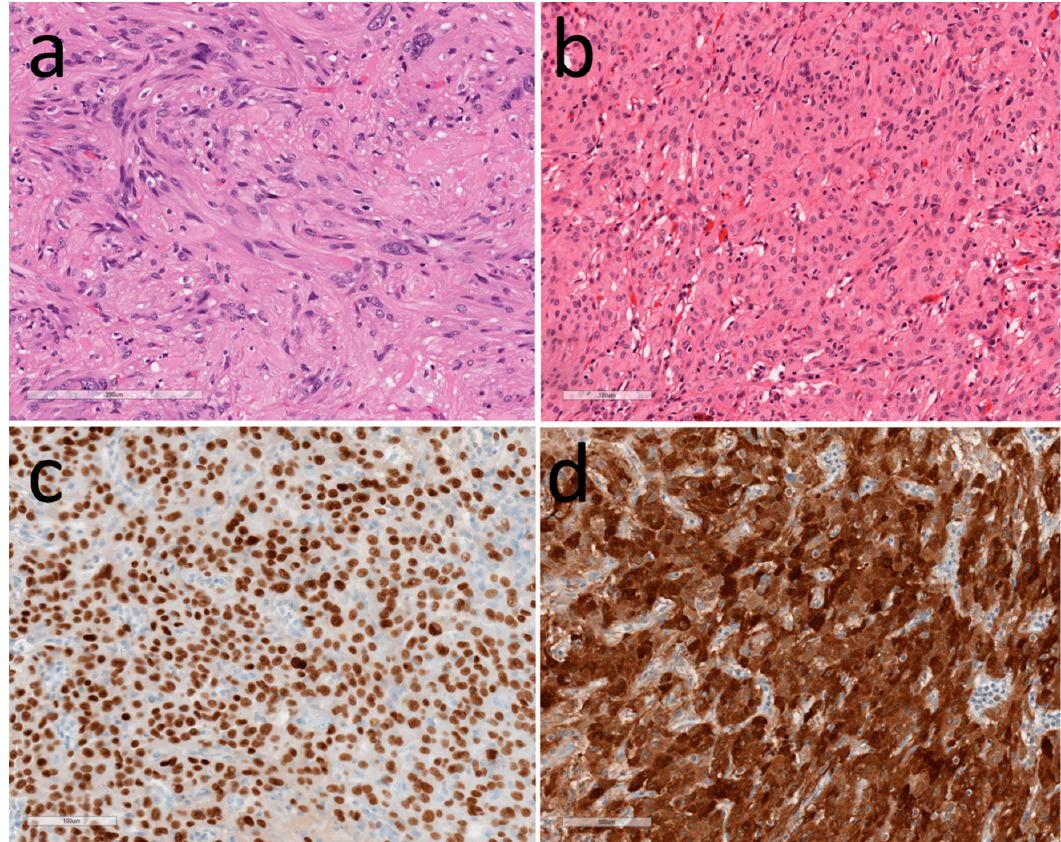
Figure 3. Pituicytomas. ( a ) H&E of a classical pituicytoma shows spindle-shaped cells forming fascicles; ( b ) An oncocytic variant that is composed of round cells with granular eosinophilic cytoplasm; ( c ) TTF1 decorates the nuclei of the tumor cells; ( d ) S100 is expressed by the tumor cells.